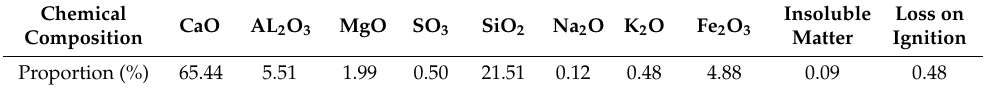
Table 7. Properties of the Portland cement.